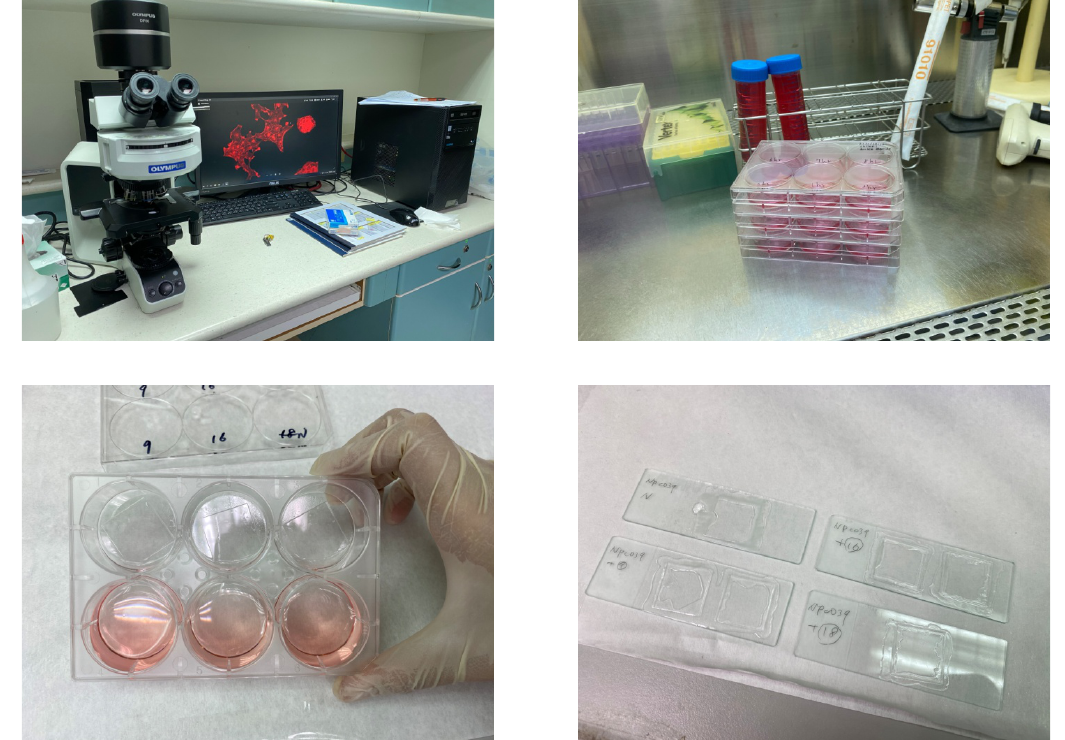
Figure 8. Experimental equipment, cell culture dishes, and cell specimens.